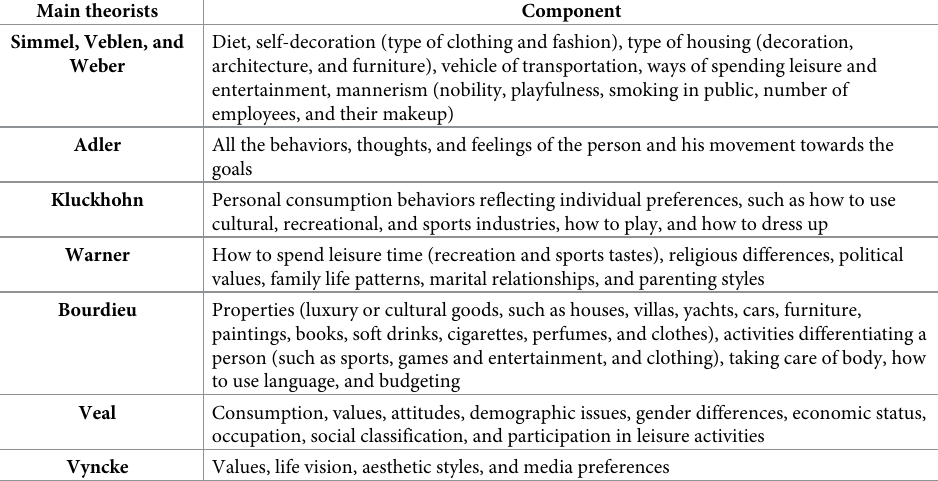
Table 1. Examples of lifestyles